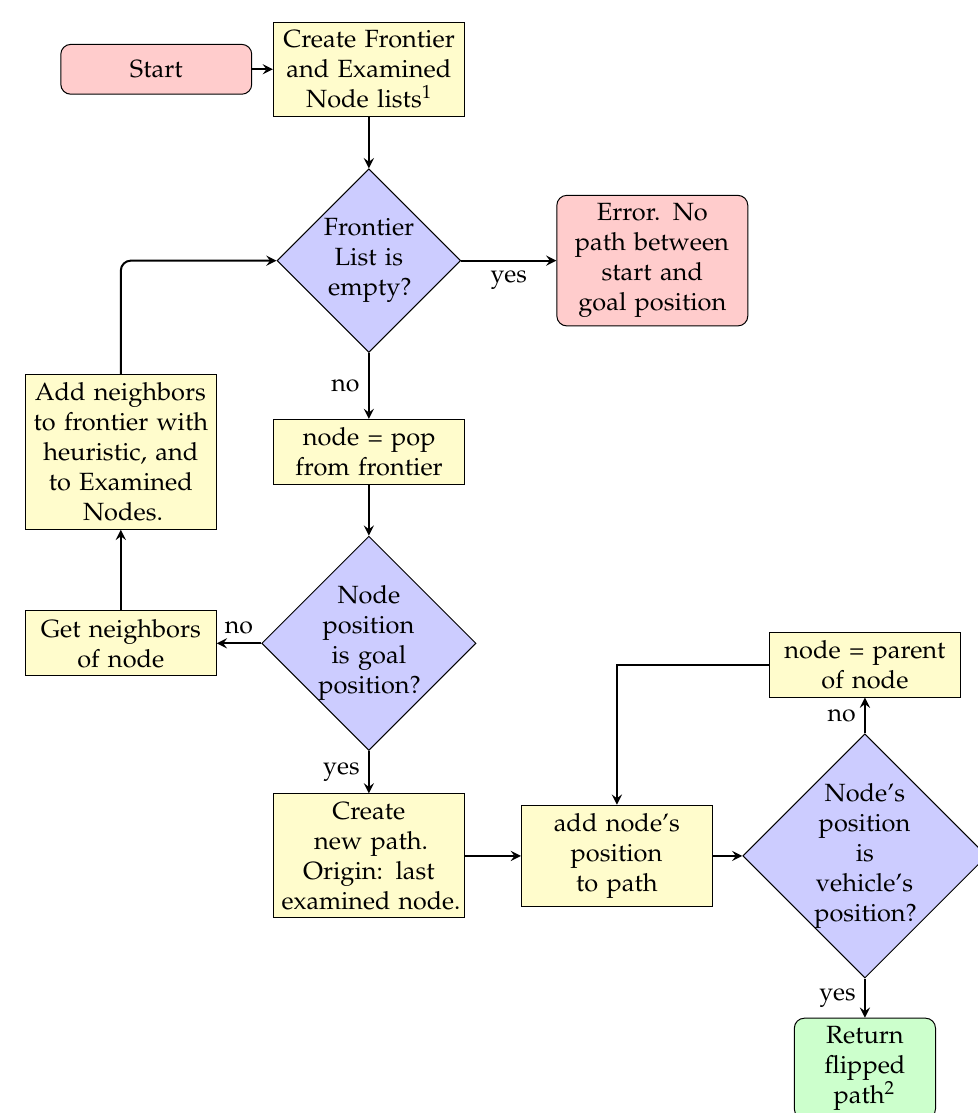
Figure 3. A* sequence diagram. 1: Both lists include the vehicle’s initial position as node. 2: The path should go from end to